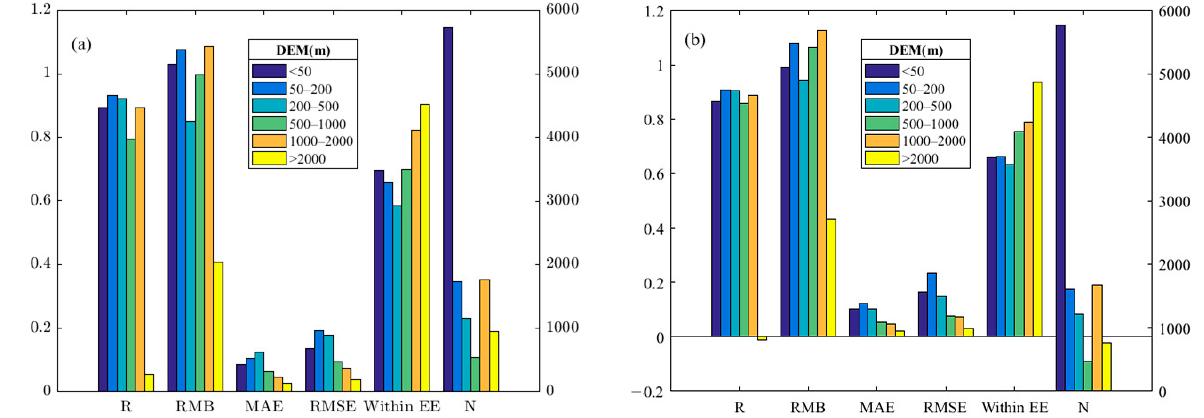
Figure 5. Comparison of the accuracy of AOD observations for MAIAC Terra ( a ) and Aqua ( b ) against AERONET measurements at different elevations.